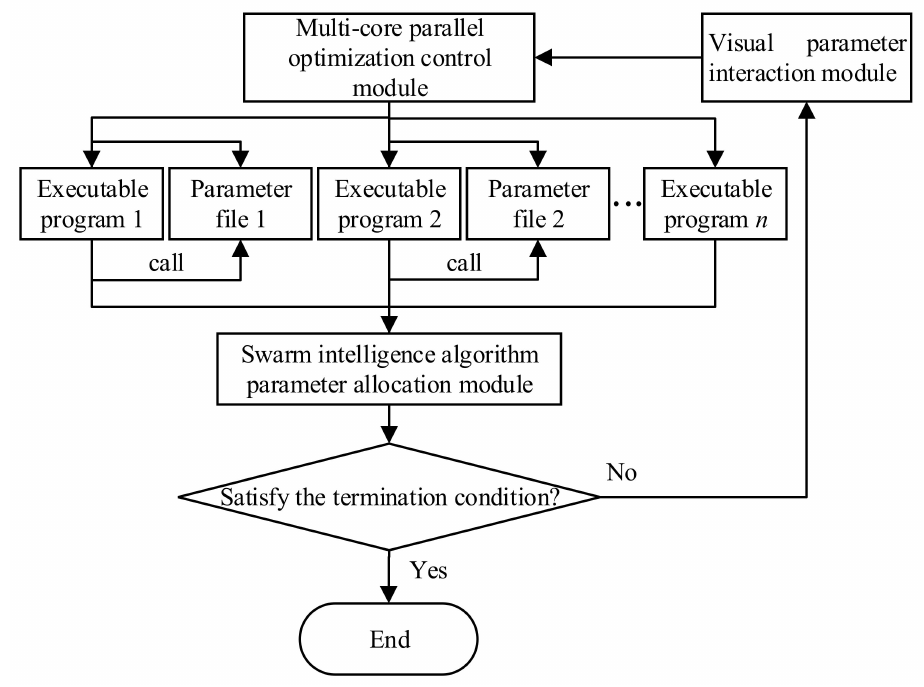
Figure 18. The frame of parallelism optimization is based on swarm